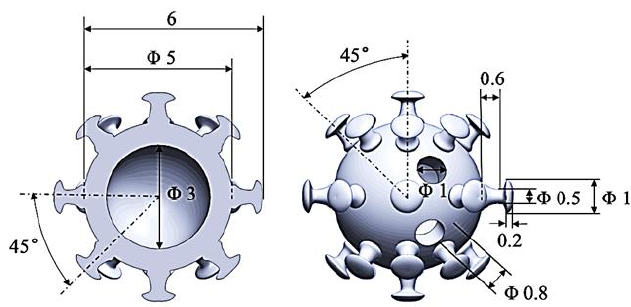
Figure 1. 3D printing phase change aggregate structure design.